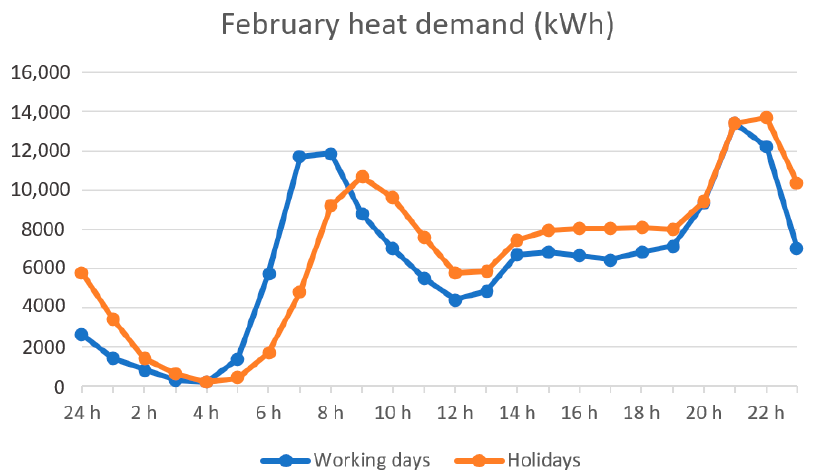
Figure 2. Hourly thermal demand for heating and DHW for the month of February. Note: vertical axis shows average energy demand in MWh, while horizontal axis the hours of a